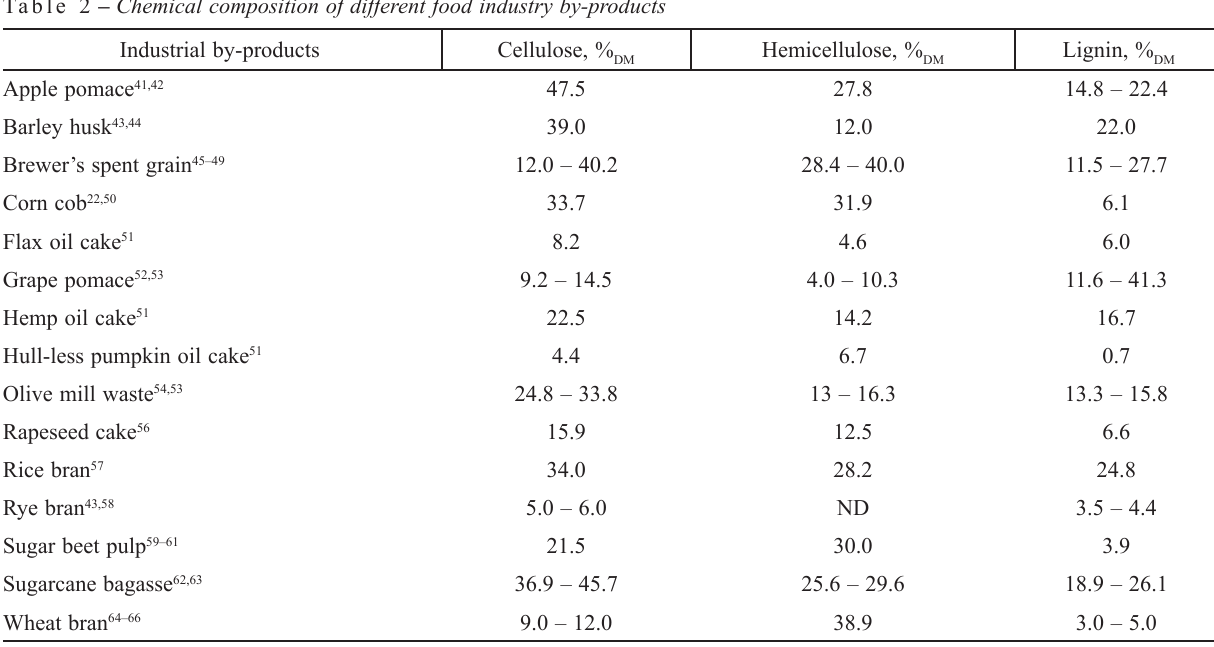
Table 2 – Chemical composition of different food industry by-products Industrial